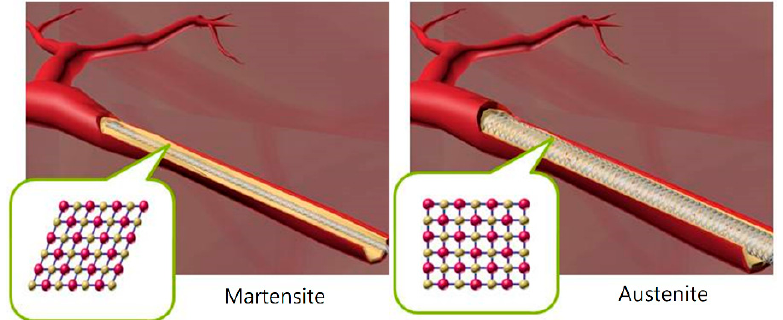
Figure 14. The SMA vascular stent for dilating the blood vessel.